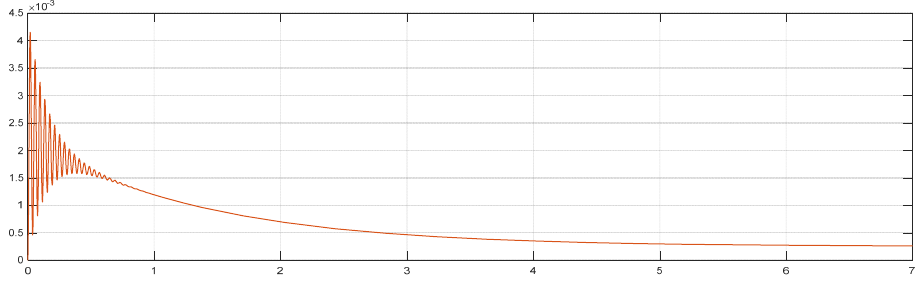
Figure 2. Dependence of the change in the twist angle ∆ φ during the acceleration Received energy-shaping control (13) provides the same behavior, as shown in Figures 1 and 2.